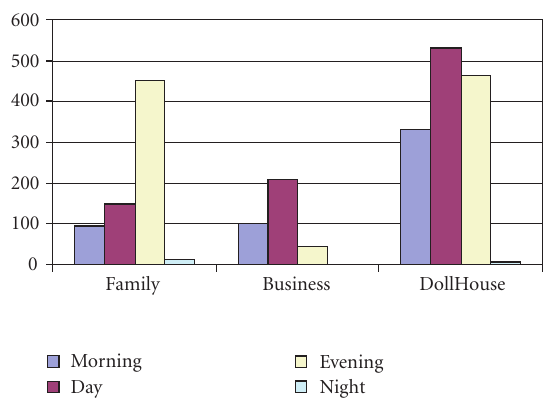
Figure 2: Average number of mCell entries per person during one- month study period.